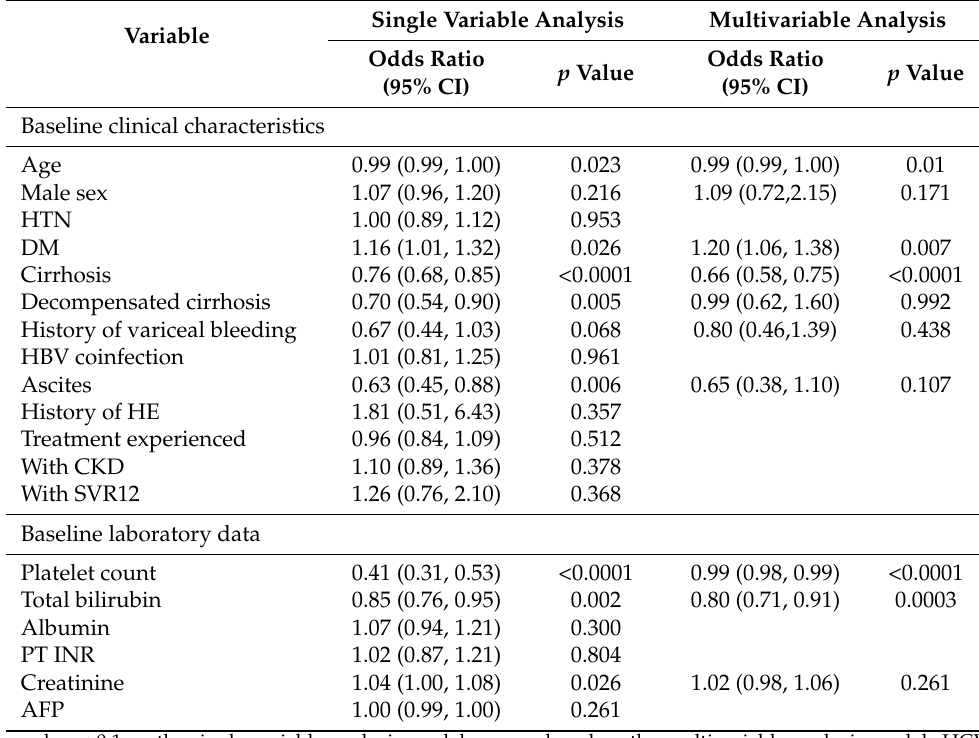
Table 2. Single variable and multivariable analyses associated with significant platelet count im- provement in thrombocytopenic HCV patients after DAA